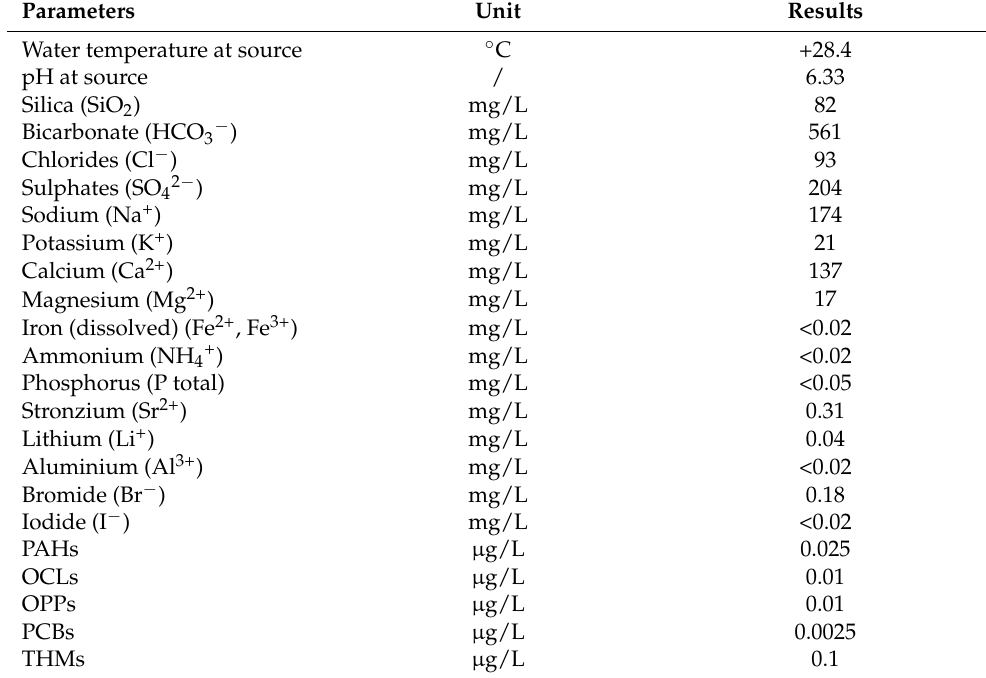
Table 1. Mineral composition of Nitrodi’s